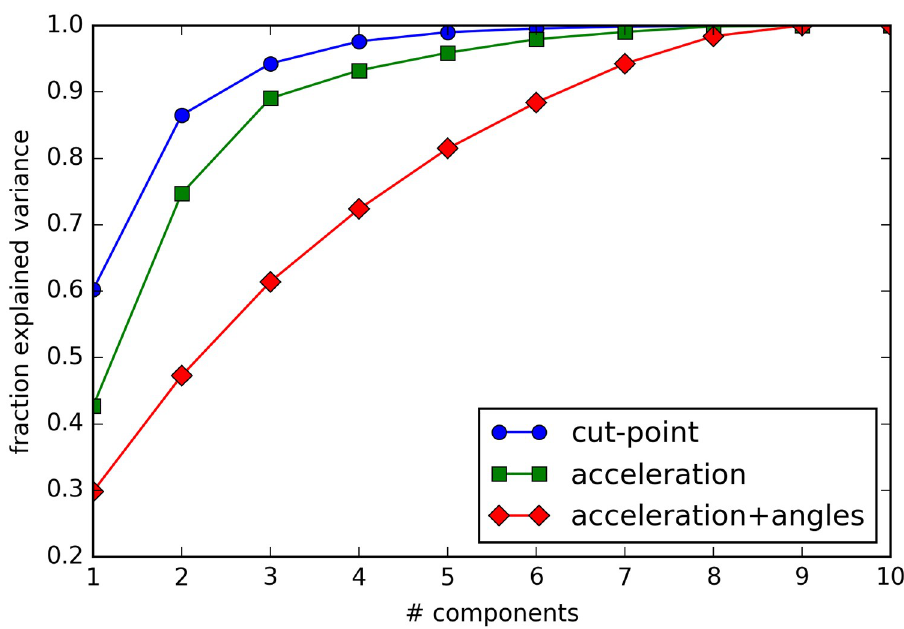
Fig 2. Scree plot showing the explained variance for principal components of time spent in cut-points categories and HSMM states for the HSMM based on acceleration and the HSMM based on